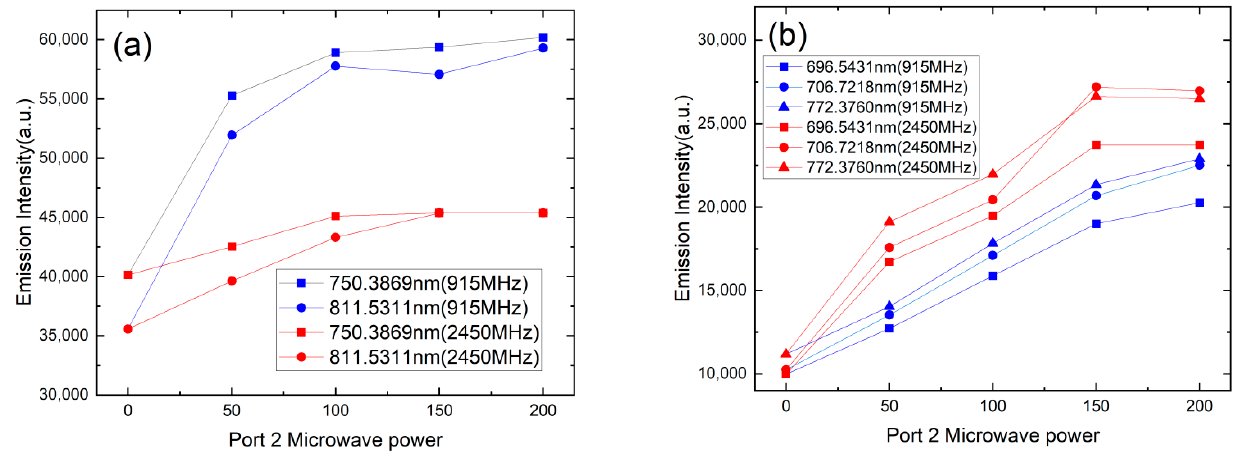
Figure 6. Intensity changes of Ar I characteristic peaks versus microwave power inputted from port 2 ( a ) 750.3869 and 811.5311 nm; ( b ) 696.5431, 706.7218 and 772.3760 nm.